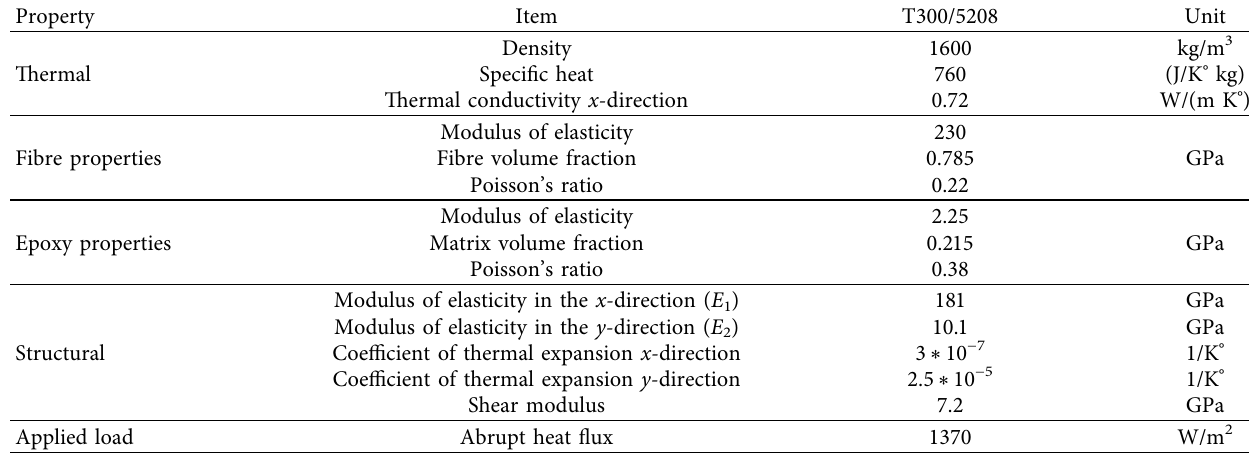
Table 1: Properties of material used in the investigation [1].